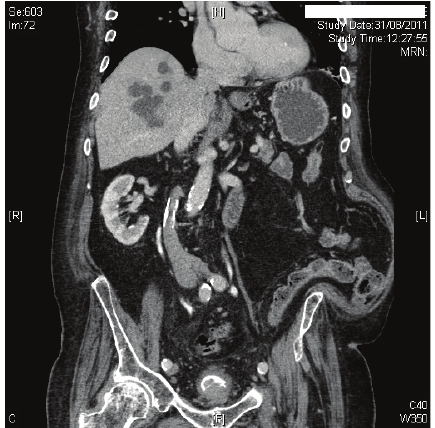
Figure 1: CT urography (coronal view) revealed an irregular mass at the base of urinary bladder.